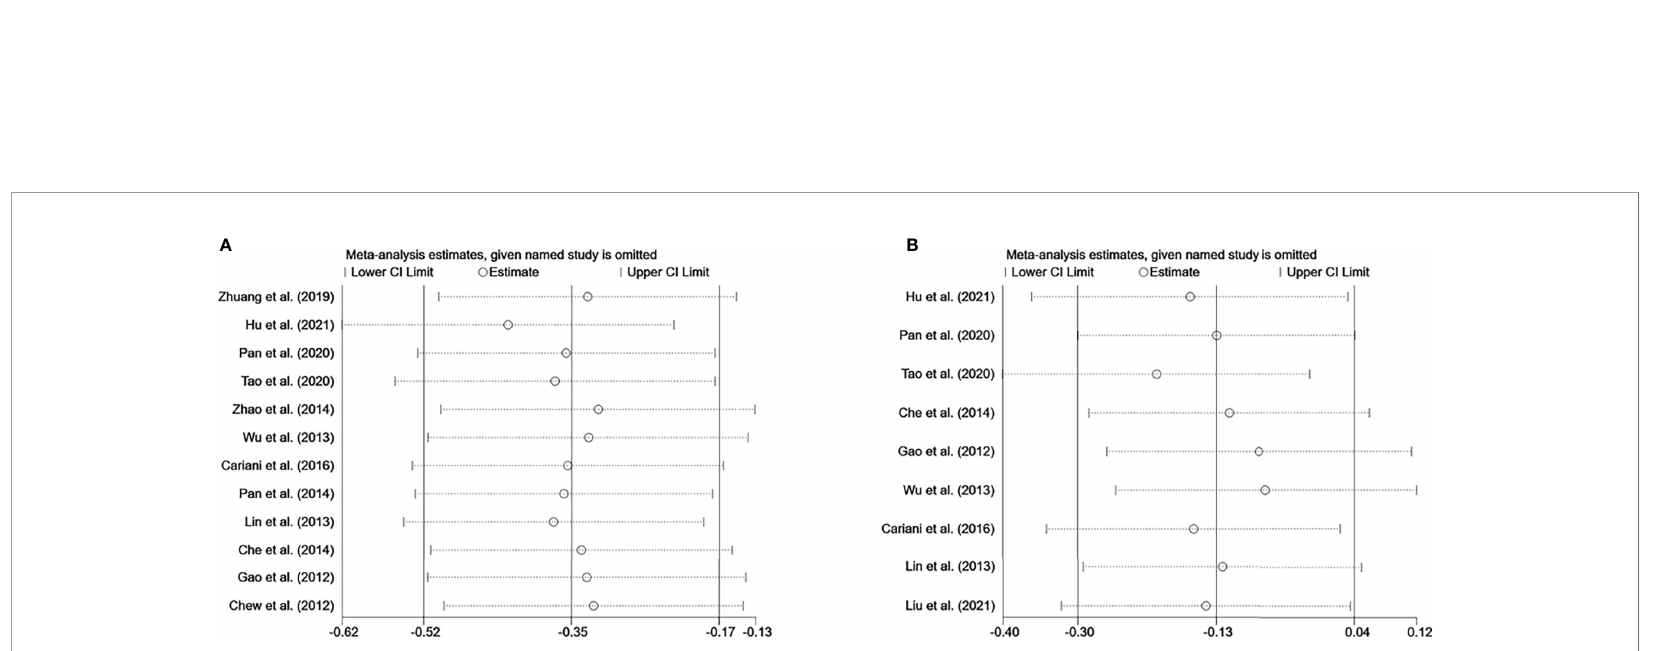
FIGURE 5 | Forest plot of NK cells inhibitory receptors/ligands in HCC. (A) Forest plot of NK cells inhibitory receptors/ligands and OS in HCC. (B) Forest plot of NK cells inhibitory receptors/ligands and DFS/PFS in HCC. CI, Con fi dence interval; HR, Hazard ratio; HCC, Hepatocellular carcinoma; NK, Natural killer; OS, Overall survival; DFS, Disease-free survival; PFS, Progression-free survival.